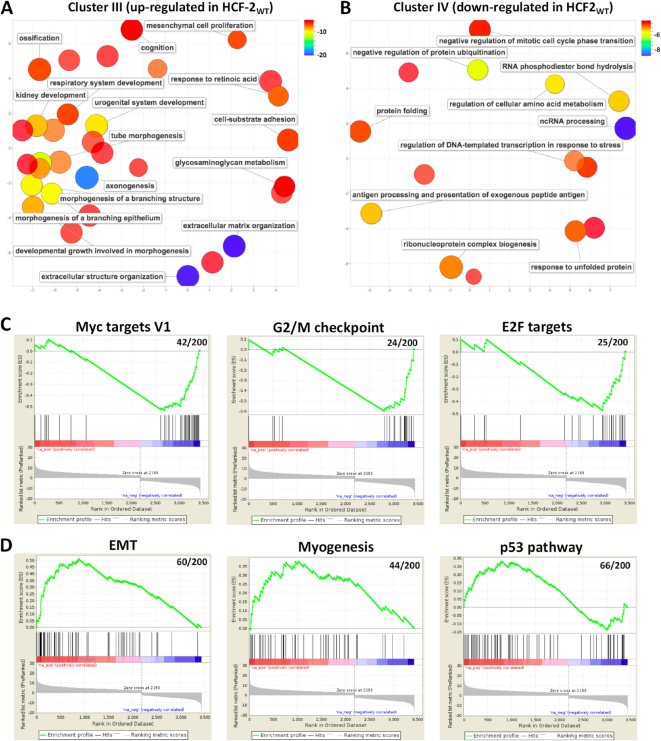
REVIGO display of GO terms associated with genes enriched in (A) cluster III (up-regulated in the HCF-2WT sample) and (B) cluster IV (down-regulated in the HCF-2WT sample). List of GO-terms generated by cluster Profiler (see Supplementary Table S3) and selected for a P value <10−06 for cluster III and <10−05 for cluster IV was analyzed using the REVIGO tool with an allowed similarity parameter of 0.7. GO-term bubbles are colored with respect to P values as indicated in the associated color scales, bubble size indicates the frequency of the GO term in the underlying GOA database. (C and D) Selected GSEA enrichment plots for Hallmark gene sets of differentially expressed genes of day 1 and 6 of the HCF-2WT-samples for (C) down-regulated and (D) up-regulated pathways. Only the hallmarks most relevant to observed phenotype are shown (for more details of GSEA Hallmark sets see Supplementary Table S4 and Supplementary Figure S9).